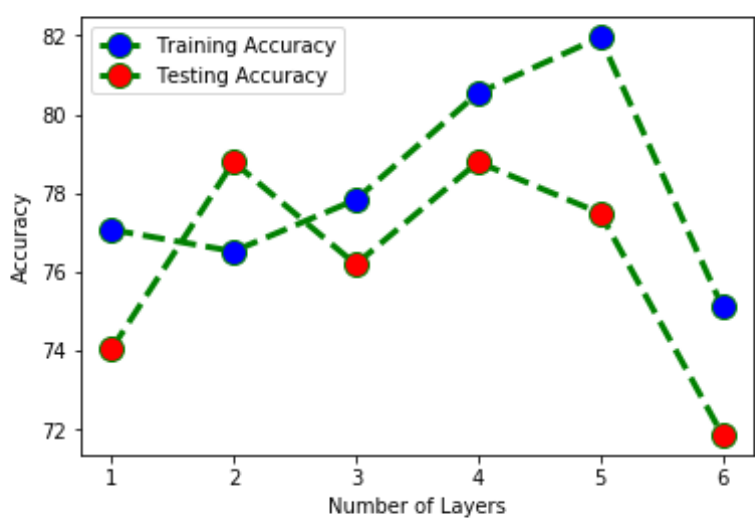
Figure 4. Performance Evaluation Based on Number of Layers